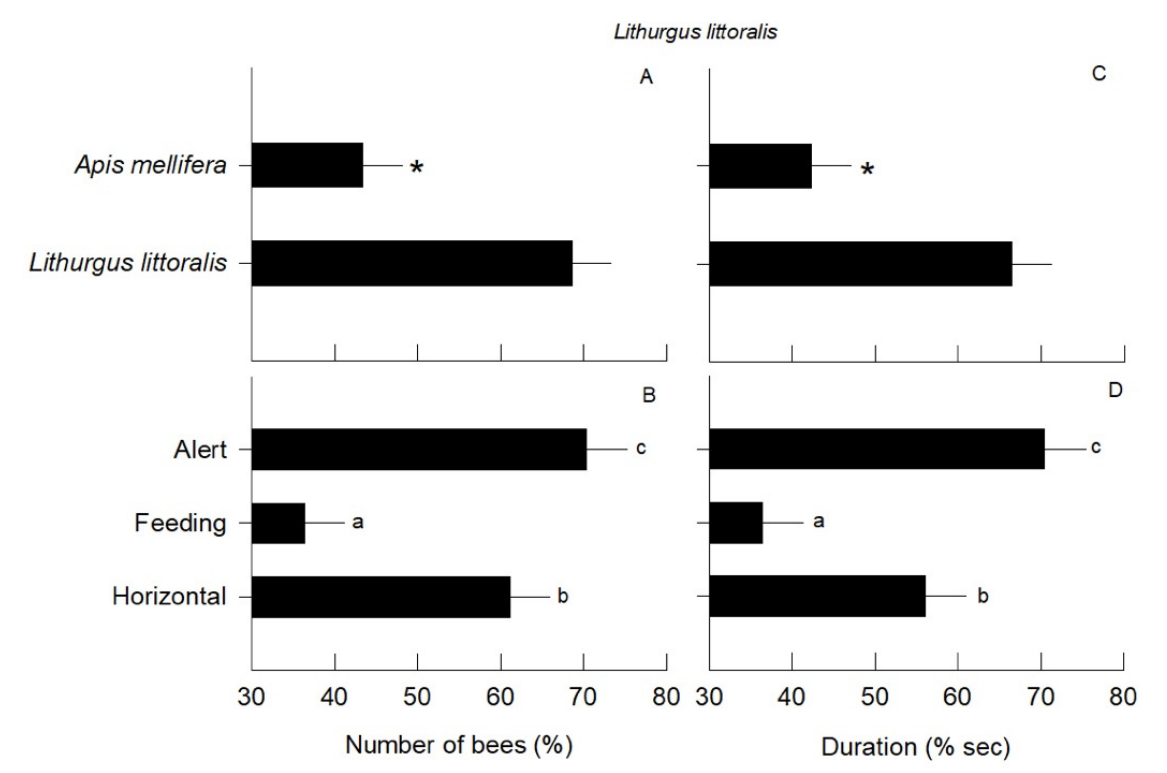
Figure 4. Mean percentage ( ± SE ) of the number of male bees of Lithurgus littoralis that display aggression in the different dummy model species ( A ) in three different body positions ( B ), as well as the percentage duration of aggression in seconds for the different dummy model species ( C ), and in three different body positions ( D ). Each graph shows the effect of the fixed factors of the two-factor GLM, and asterisks and small letters (a, b, and c) on the bars show the significant differences between mean values.